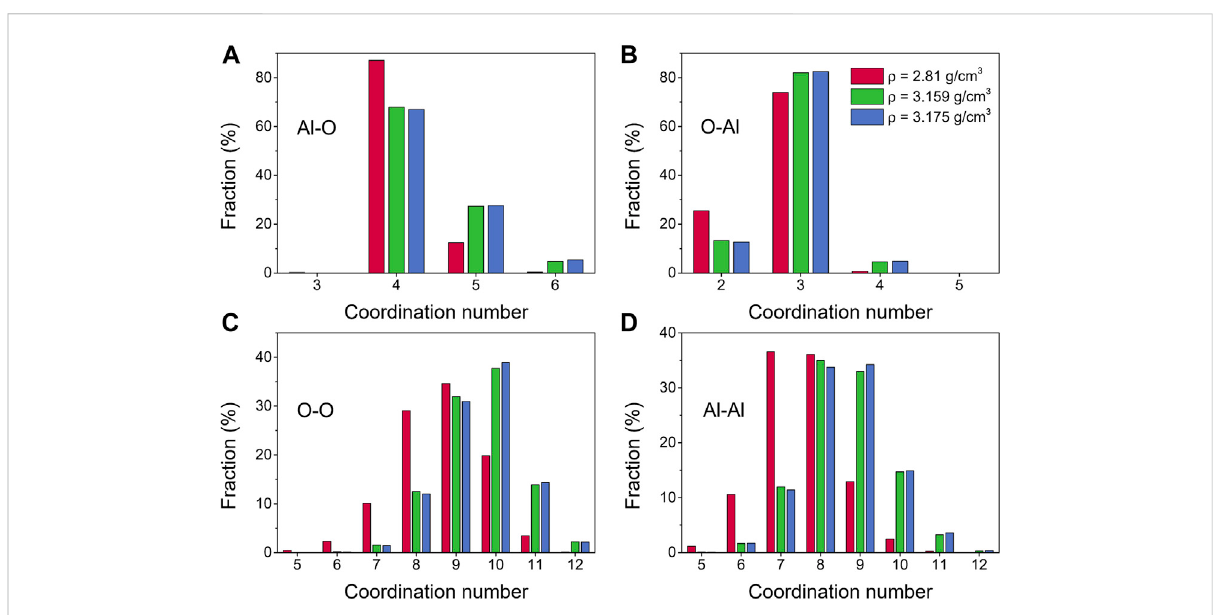
FIGURE 2 Coordination number distributions for amorphous alumina at 300 K and three densities, (A) Al-O, (B) O-Al, (C) O-O and (D)